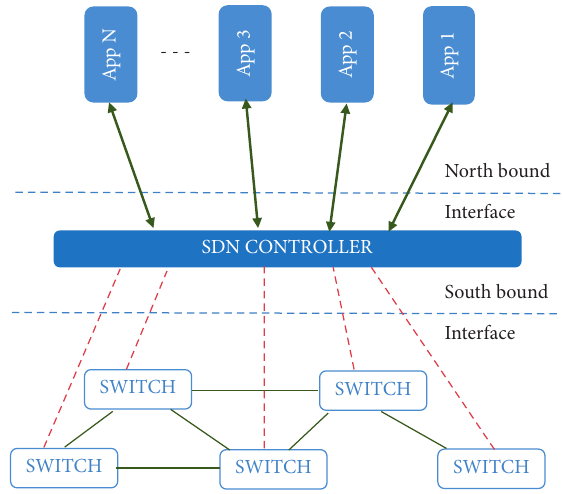
Figure 1: Architecture of SDN